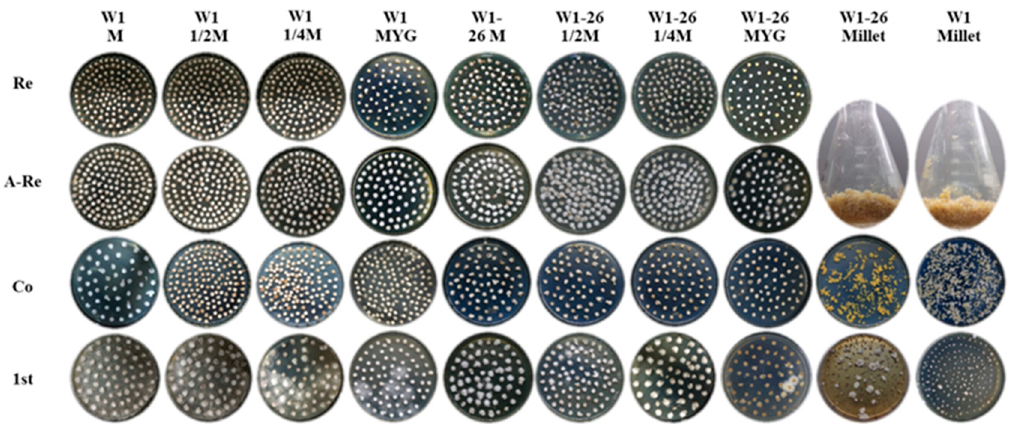
Figure 4. The transformation efficiency as affected by different mediums. Re: Mycelial plugs cultured in MYG medium for rejuvenation; A-Re: Mycelial plugs overgrown with freshly germinated hyphae after rejuvenation in MYG medium; Co: Cocultivation; 1st: First selection. M: Sawdust medium. Table 2. The effect of activation medium and strain karyotype on transformation efficiency of L. edodes. Strains Medium